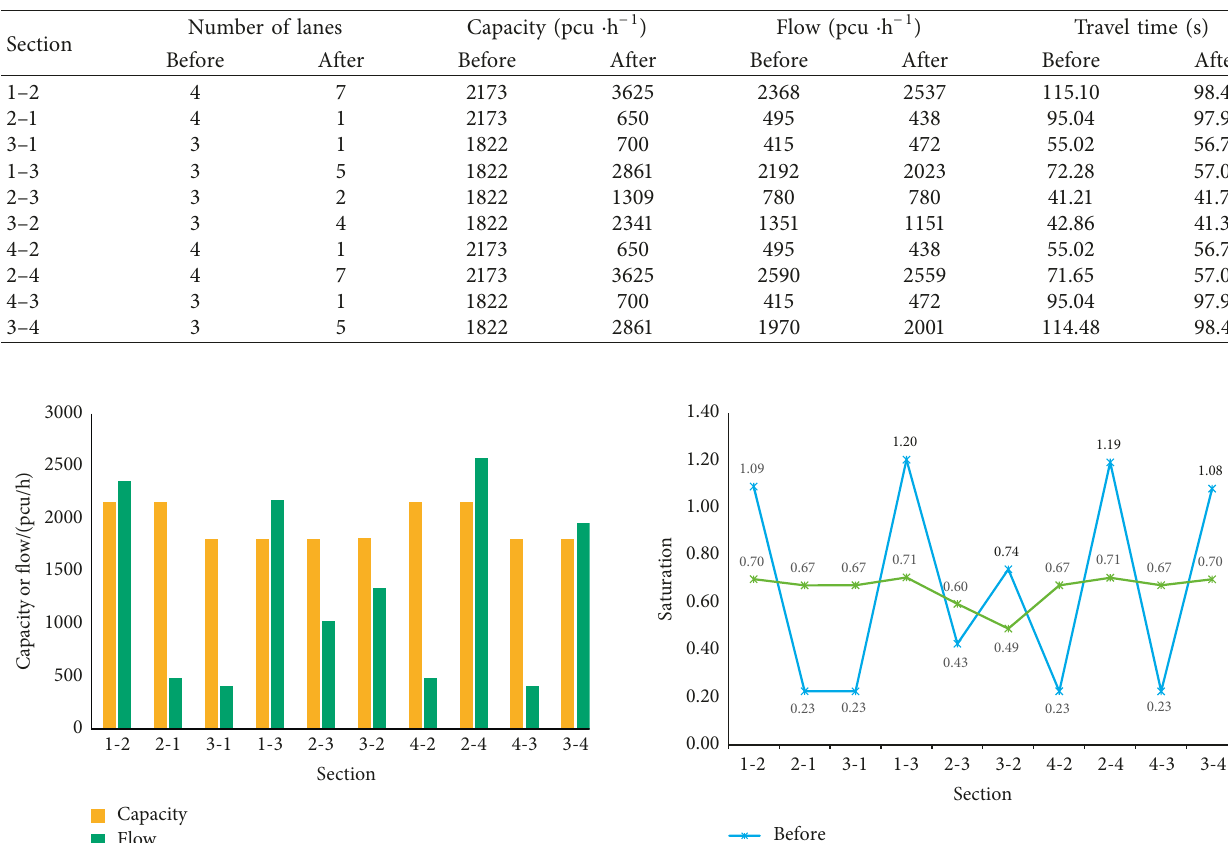
Table 3: Characteristic values of sections before and after optimization.